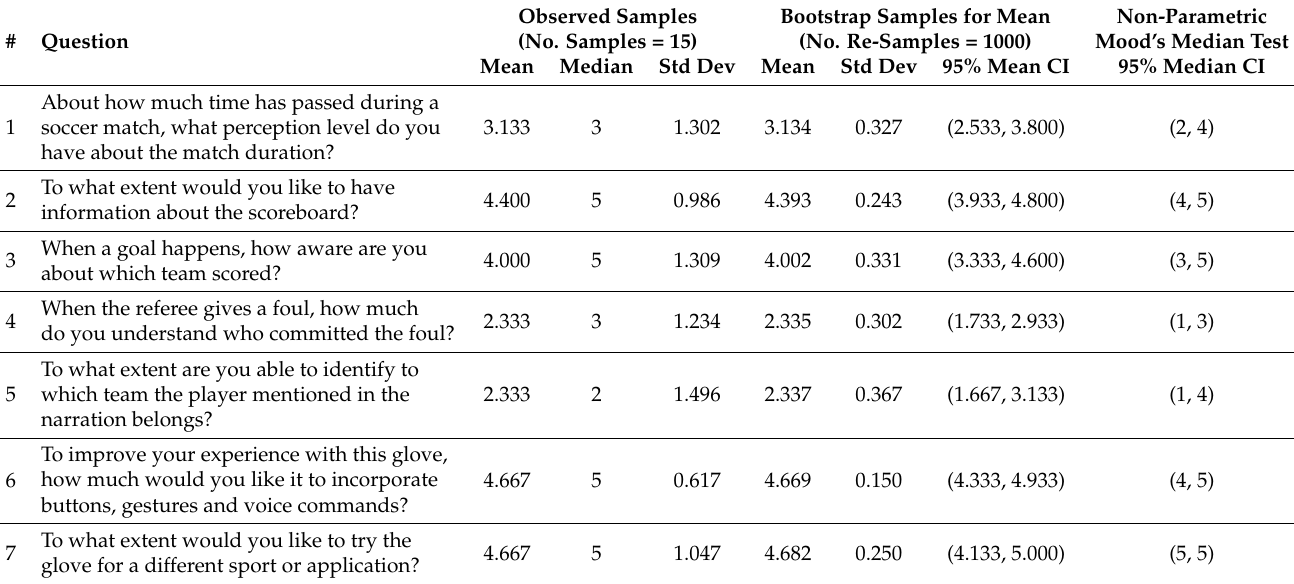
Figure 21. Do you know the team scores when a goal happens? Table 5. Questions for requirements of future use and improvements to the device with statistical